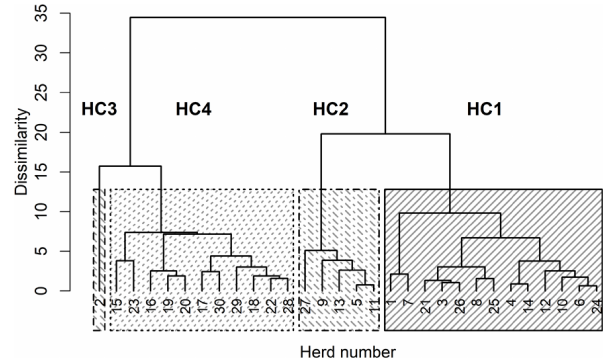
Figure 2. Dendrogram of the herds merged to herd clusters by clus- tering of variables combined with agglomerative hierarchical clus- tering (CoVAHC). Each block with specific pattern represents one